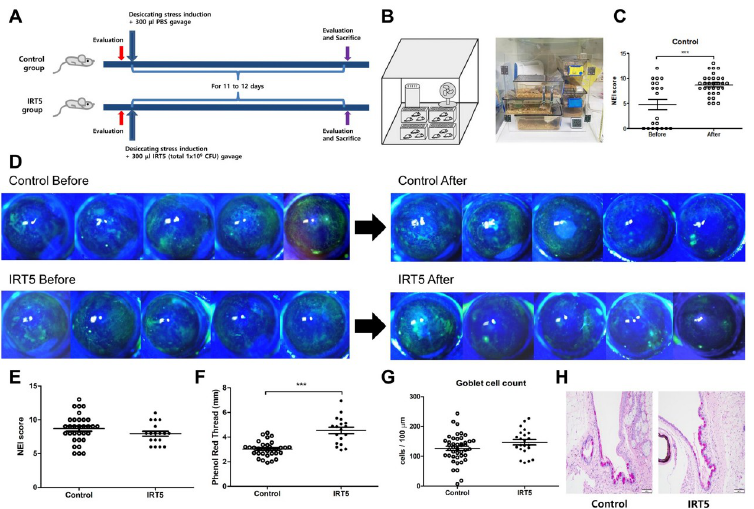
Fig 1. Environmental dry eye induction design and clinical results. Eight-week old male C57BL/6 mice were divided into control and IRT5 groups and underwent desiccating stress induction with oral gavage of either 300 μ L PBS or 1 x 10 9 CFU IRT5 probiotics powder in 300 μ L PBS, both groups for 11 to 12 days (A). Simultaneously, all mice were exposed to drafty low humid (30–35%) environment all day for 11 to 12 days (B) with sterile intraperitoneal injection of scopolamine hydrobromide (Sigma, Saint Louis, USA) (0.5 mg / 0.2 ml) three times a day. Significant NEI score increase in the control group indicated appropriate desiccating stress induction (p < 0.001) (C). Representative corneal fluorescein stained photos of 5 mice in each group are shown in D. There was no difference in NEI score but significant increase in tear secretion was observed in IRT5 group (p < 0.001) (E and F). There was no difference in goblet cell density between groups, though IRT5 group showed a slight increase (p = 0.103) (G and H). NEI score: National Eye Institute score. Statistical analysis with error bars indicating mean and SEM of data points by Mann– Whitney U test: ��� p <